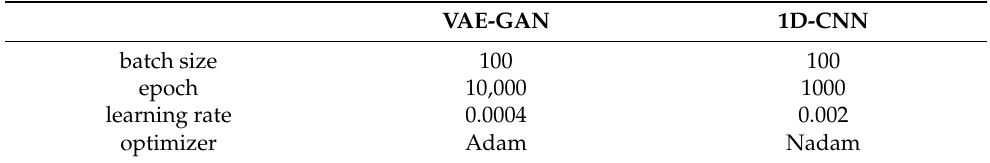
Table 1. Hyperparameters of training models.